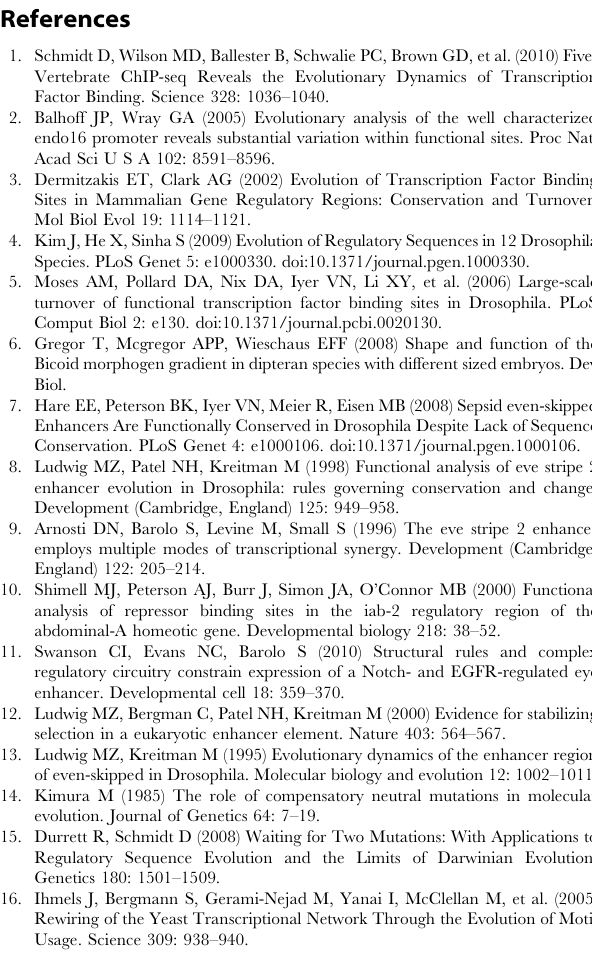
Figure S8 A geneaology tree based on 10 kb CRM sequences for 162 lines from DGRP and the Berkeley reference sequencing strain. The tree is built in MEGA using maximum likelihood method, based on 10 kb sequence alignments. It is rooted with one sequence from a closely related species D. sechellia as an outgroup (bold and blue). The reference sequencing strain (referred to as lab, bold and red) is obviously inter-mingled with the other 162 lines. A similar procedure on 3 different 10 kb sequences sampled from the genome produced similar shaped trees with the lab line embedded among the 162 lines, although the exact orders of branches are not the same, reflecting different geneaologies between regions in the genome. Table S1 CRM studied in this study. Table S2 Percentage of gain and loss of TFBS predicted by two set of cutoffs. Table S3 The pattern of excess for aff-dec mutations in sim is robust to choices of cutoff. Table S4 TF protein sequence divergence in different functional regions between mel and sim . Table S5 PWM derived from SELEX sequences using